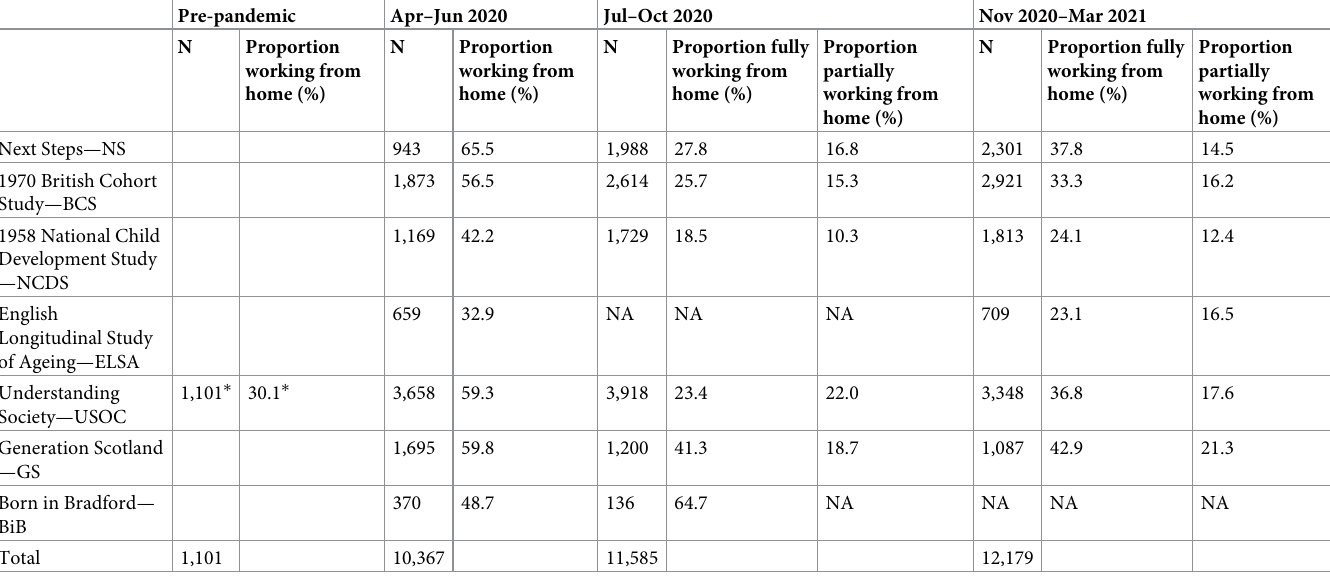
Table 1. Home working by time point across the 7 studies (weighted data).